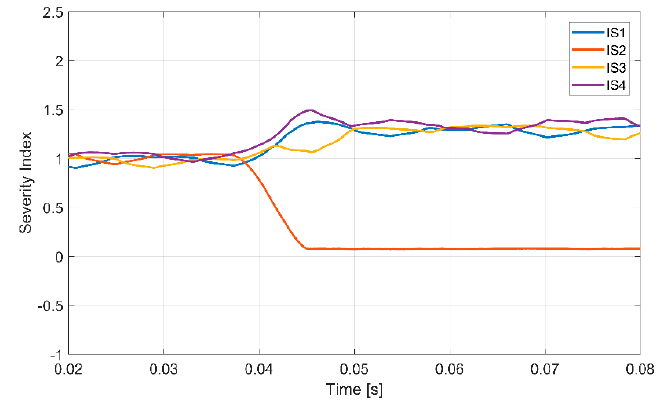
Figure 20. Motor winding currents of the SRM at 1200 rpm in normal operation and open-circuit failure of power device S 1 B (experimental result).